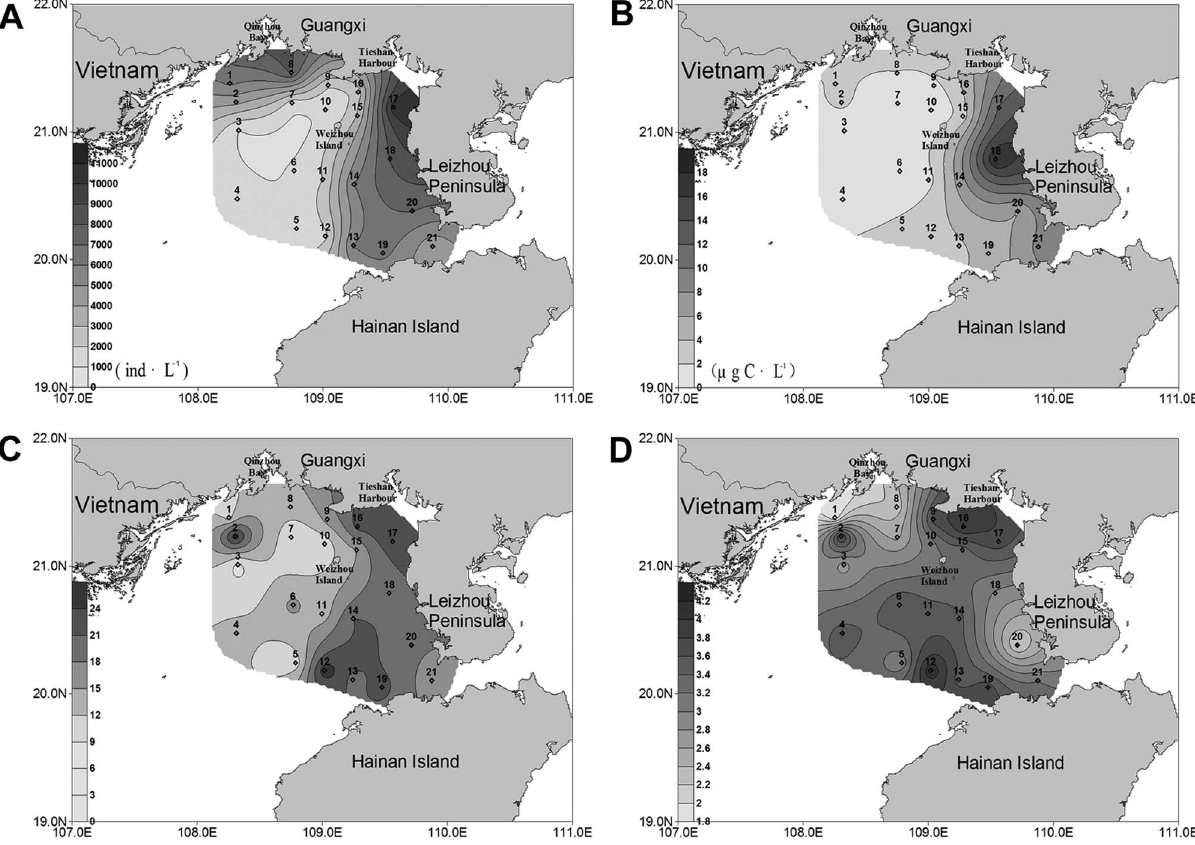
Figure 2. Horizontal distribution of planktonic ciliates in the surface layer of the northern Beibu Gulf. (A) Horizontal distribution of abundance. (B) Horizontal distribution of biomass. (C) Horizontal distribution of species number. (D) Horizontal distribution of diversity. The horizontal axis and the vertical axis expressed the gradients in longitude and latitude, respectively. (TIFF).